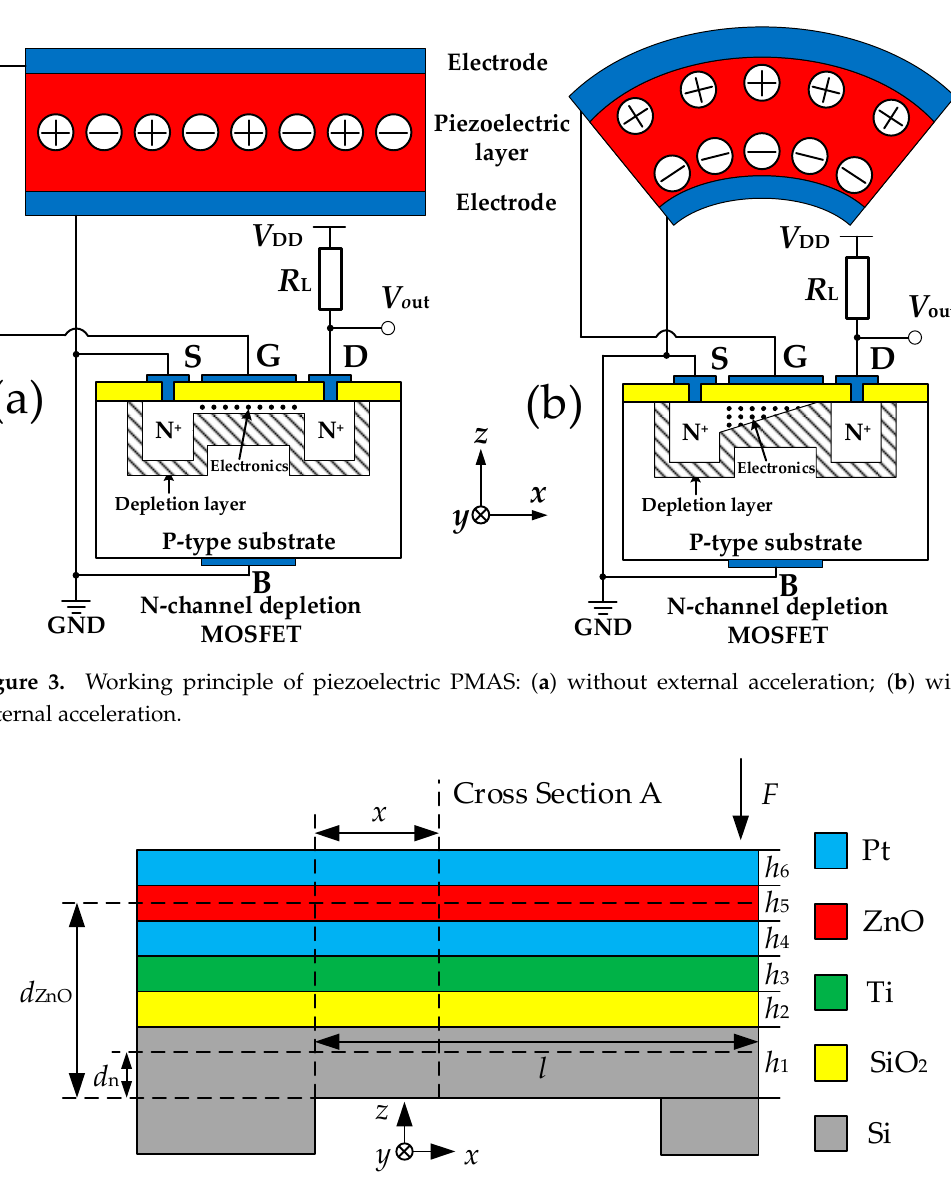
Figure 4. Stress analysis diagram of piezoelectric beam structure.